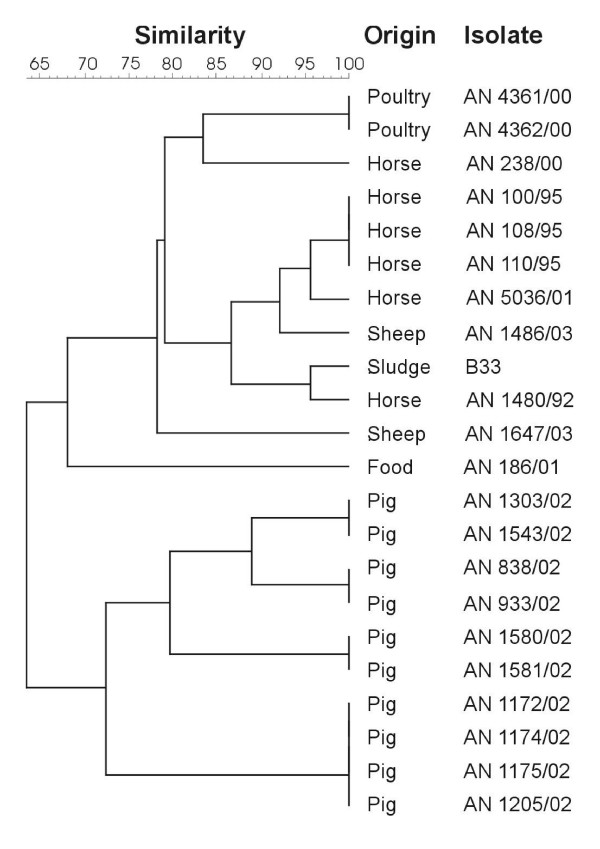
Cluster analysis of SmaI-digested DNA from the 22 cpb2-positive isolates of C. perfringens.